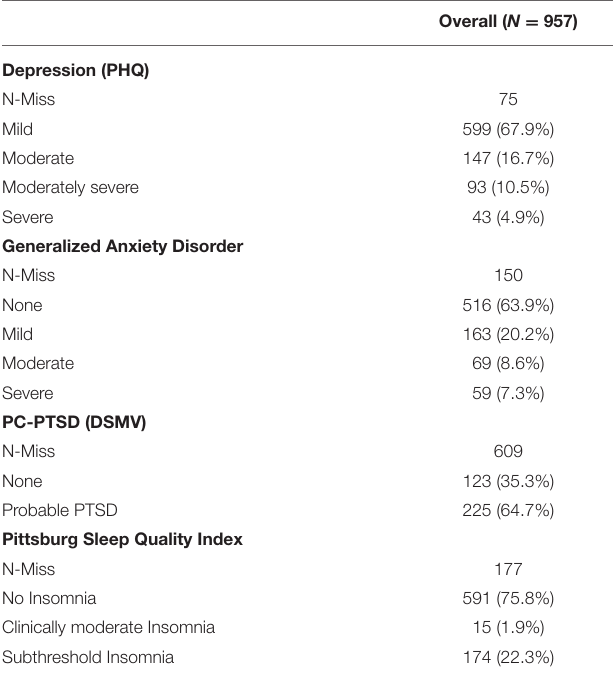
TABLE 5 | Frequency of various mental disorders among Kenyan Healthcare